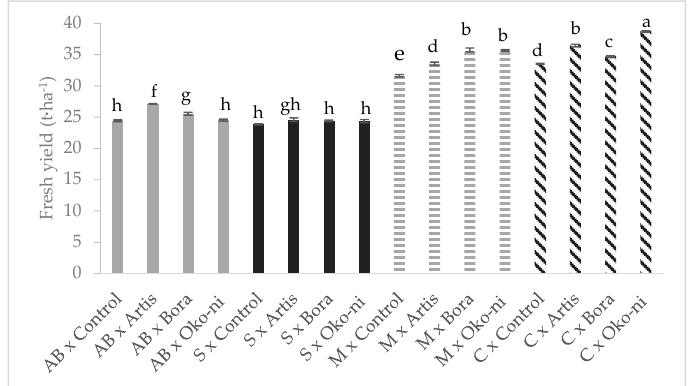
Figure 1. Interaction effects of cultivar and myco-biocontrol product on fresh yield of basil. Values with the same lower-case letters are not statistically different at p < 0.05 according to Tukey’s test.